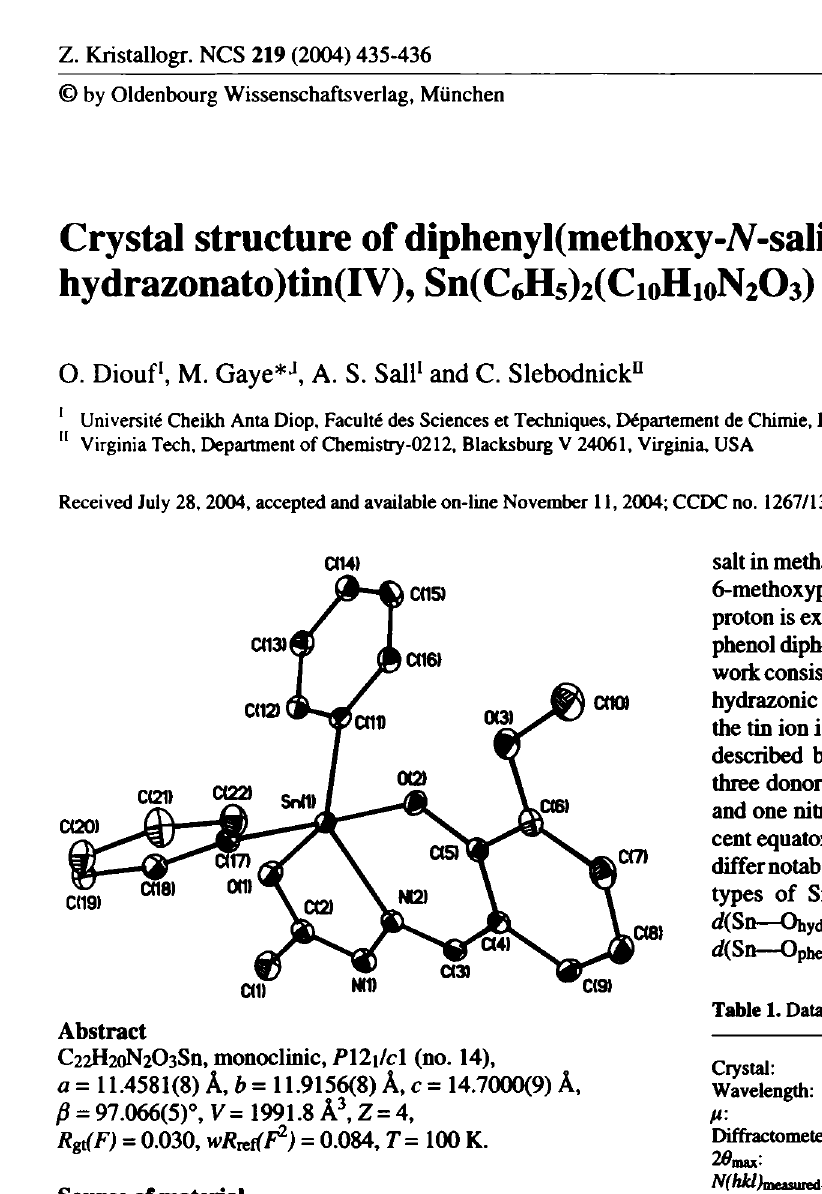
Table 2. Atomic coordinates and displacement parameters (in Â 2